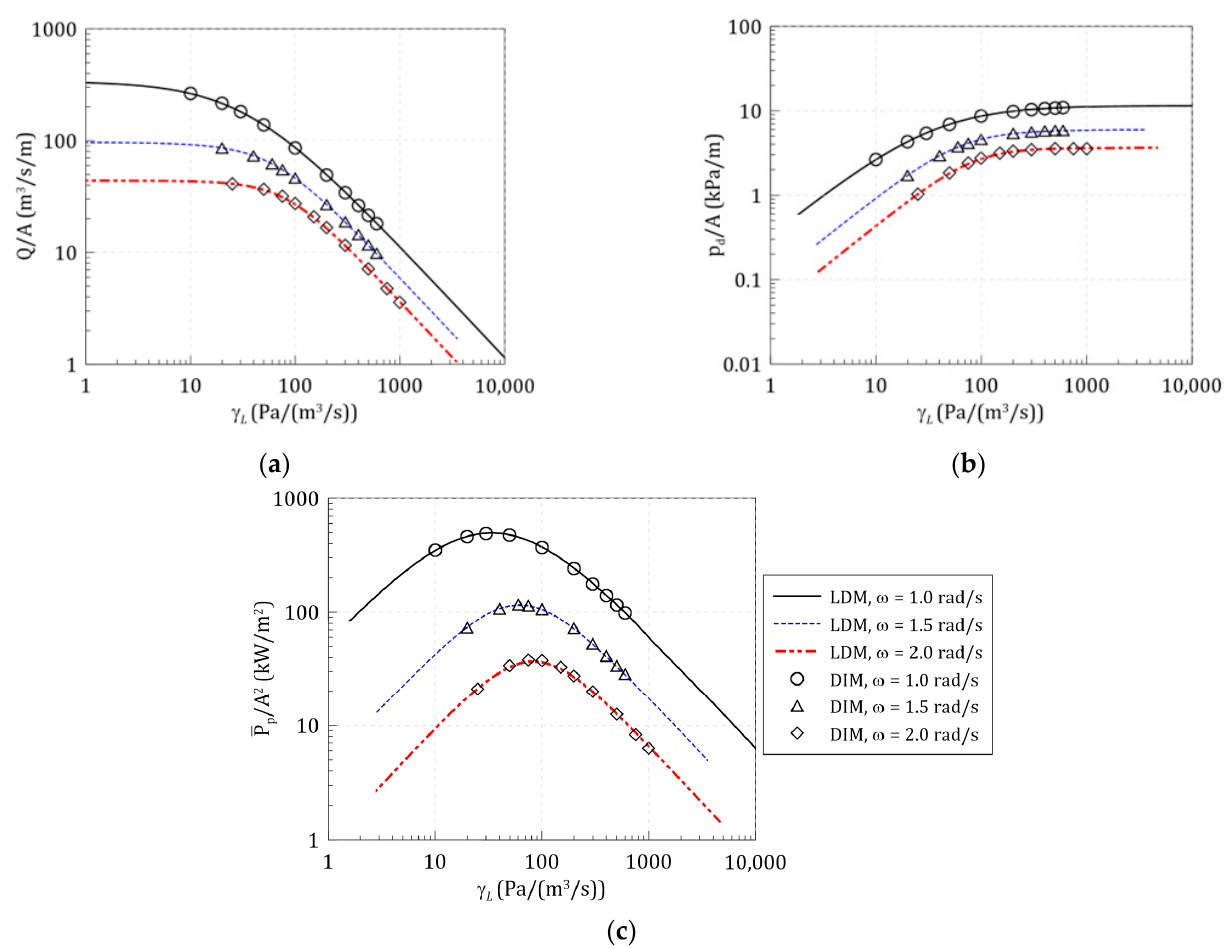
Figure 13. Comparison of numerical results between linear decomposition method and direct interaction method under various linear pressure drop coefficients: ( a ) airflow; ( b ) pressure drop; ( c ) pneumatic power.